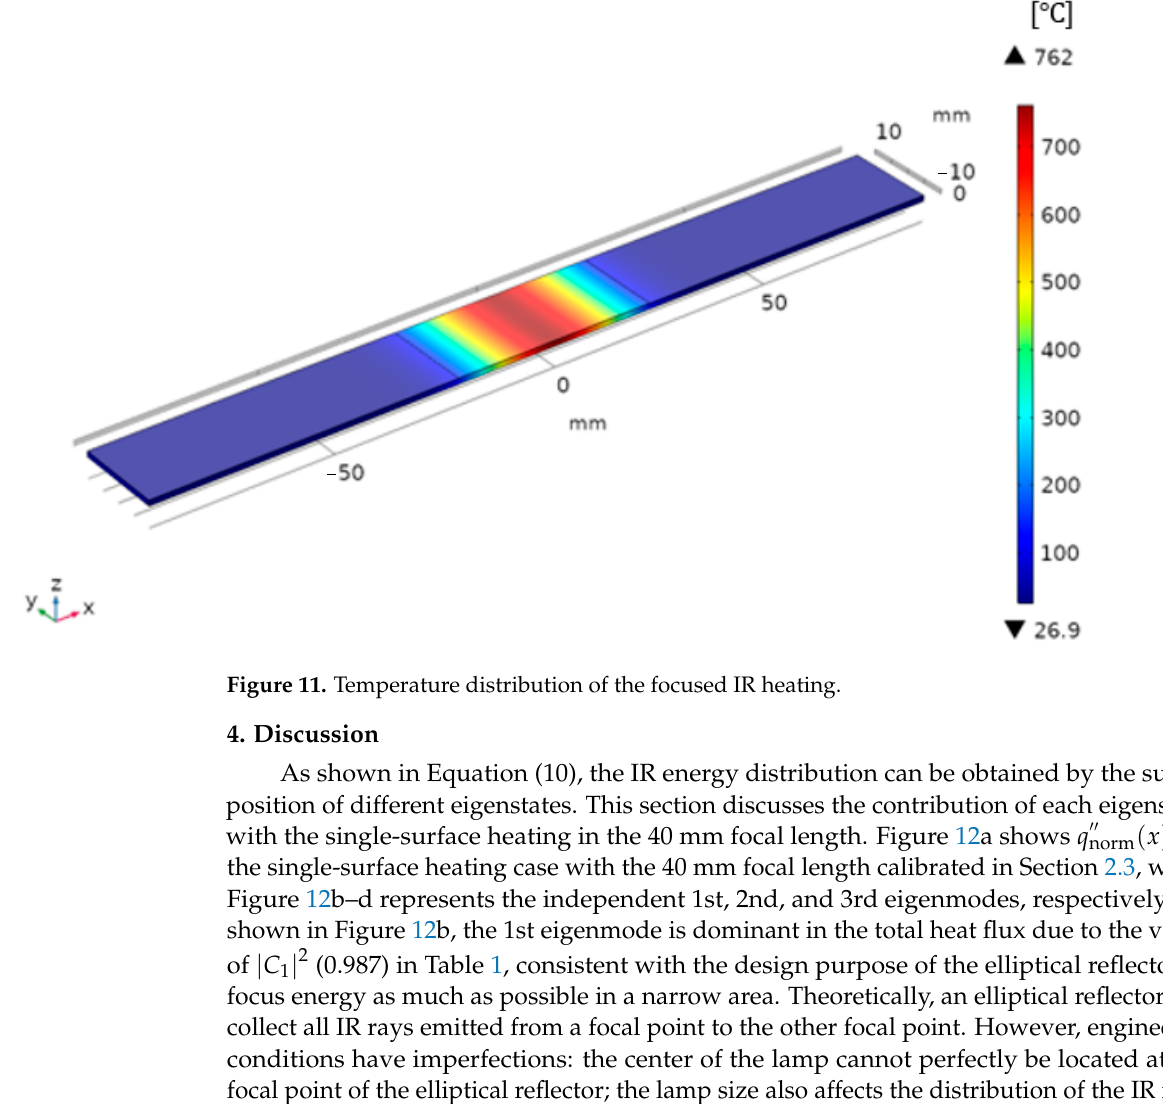
Figure 10. Temperature surface with respect to position and time: ( a ) Single-surface heating with the 20 mm focal length; ( b ) Double-surface heating with the 20 mm focal length; ( c ) Single-surface heating with the 40 mm focal length; and ( d ) Double-surface heating with the 40 mm focal length.